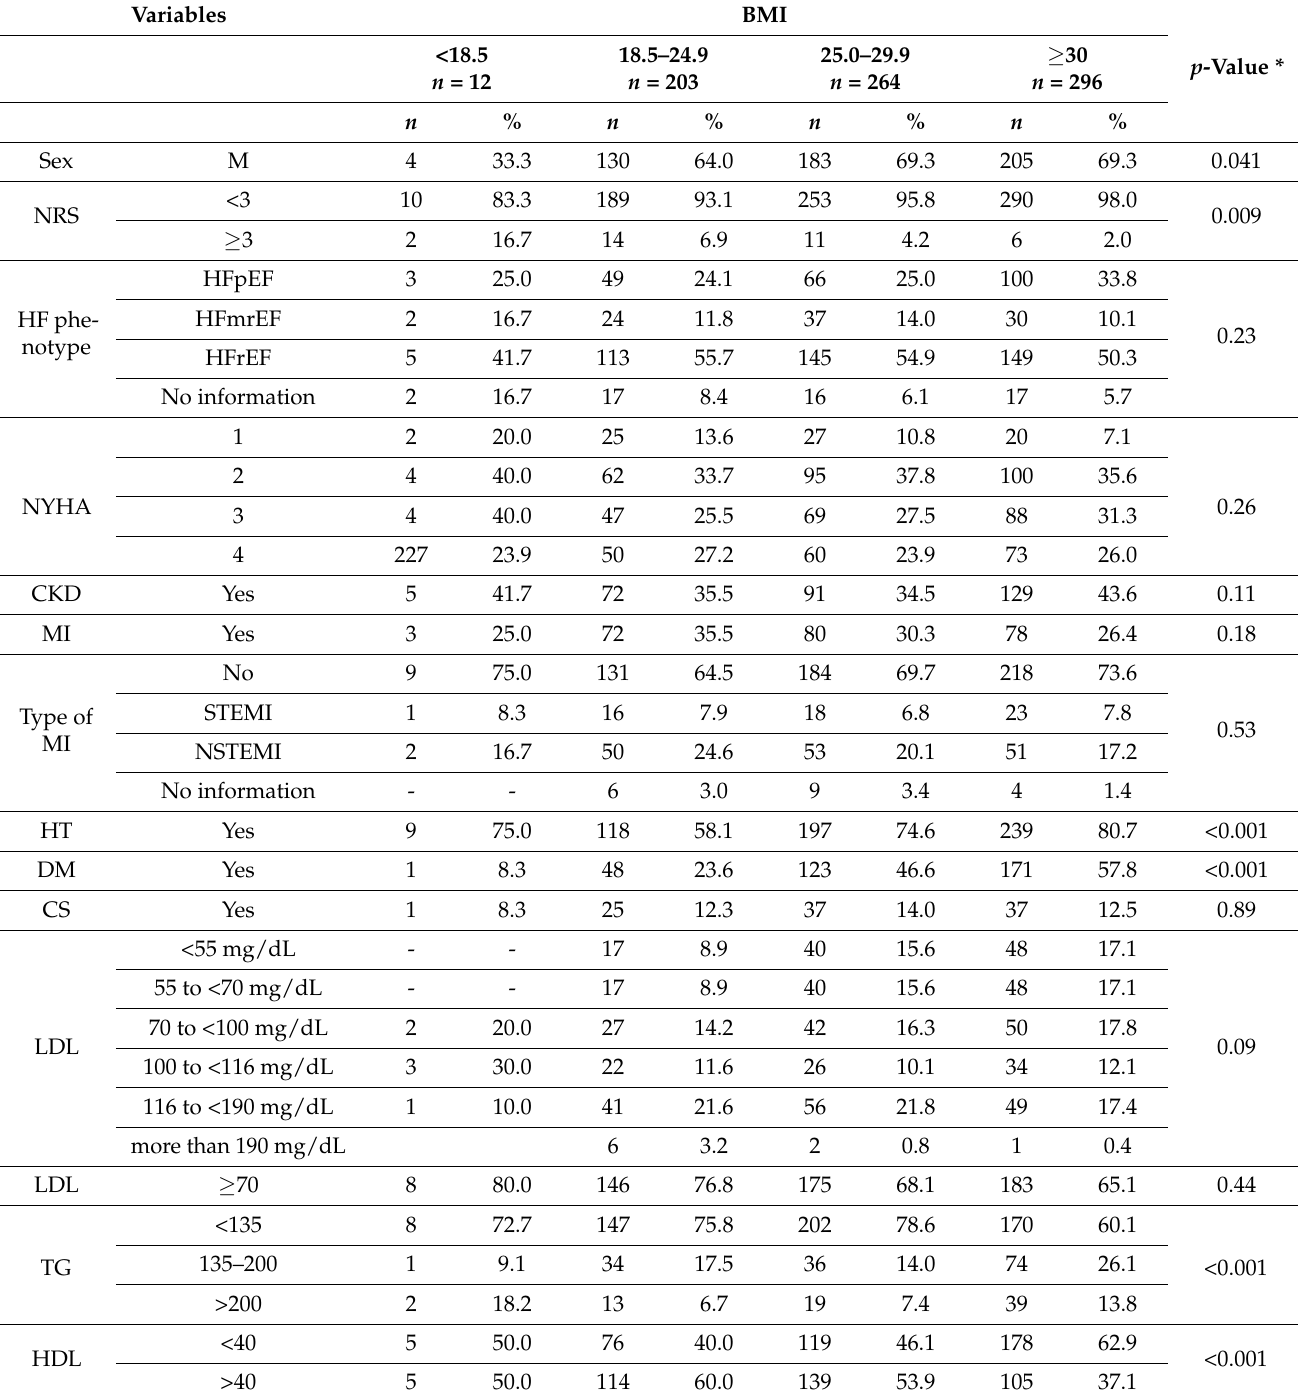
Table 2. The comparison of assessed parameters (qualitative variables) with the ranges of BMI (WHO criteria) values.